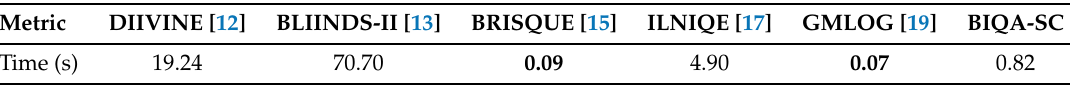
Table 9. Comparison of computation time on LIVE [28] database. The best two algorithms are highlighted in